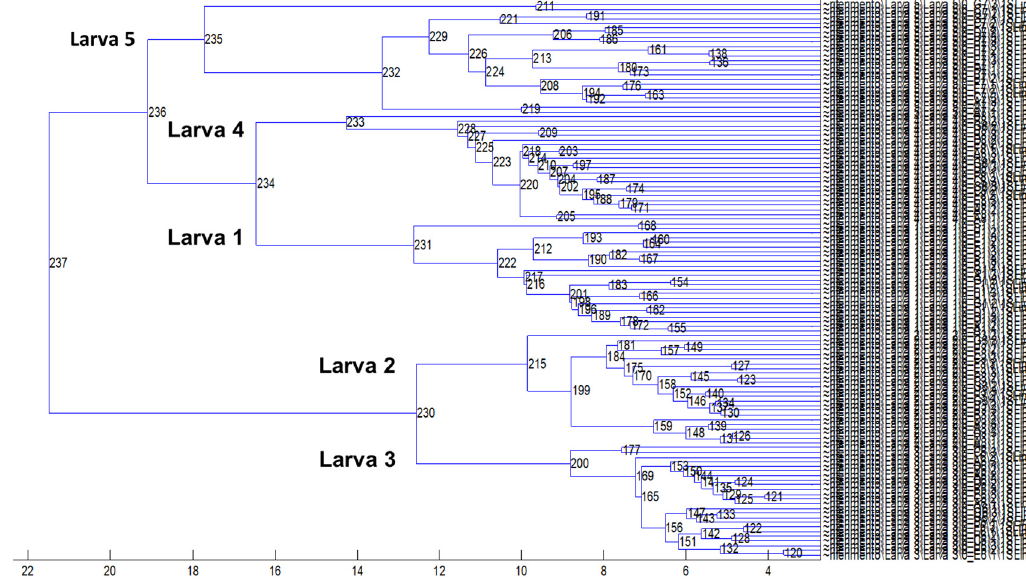
Figure 4. Spectra dendrogram (by unsupervised hierarchical clustering) obtained by analyzing all MALDI–TOF MS spectral replicas from Anisakis larvae.